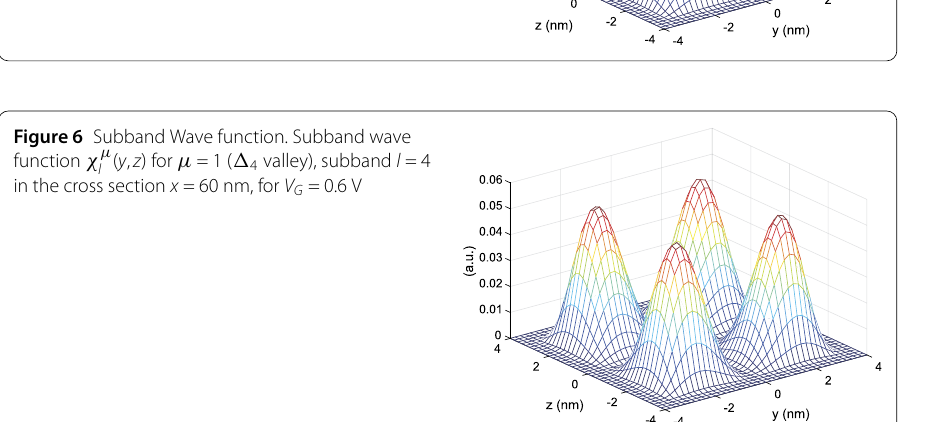
Figure 6 Subband Wave function. Subband wave function χ μ